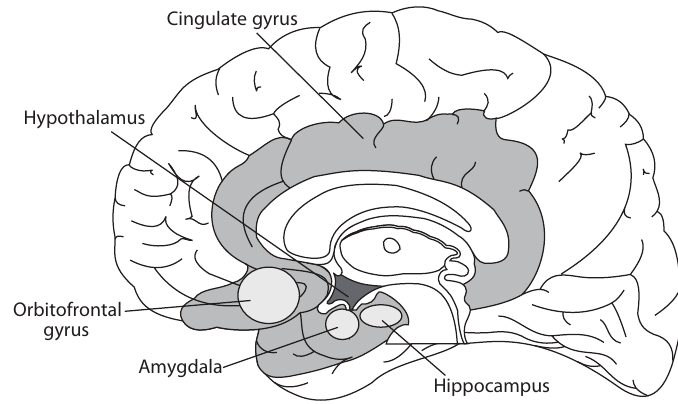
FIGURE 1: Anatomical illustration of important areas of the limbic system.